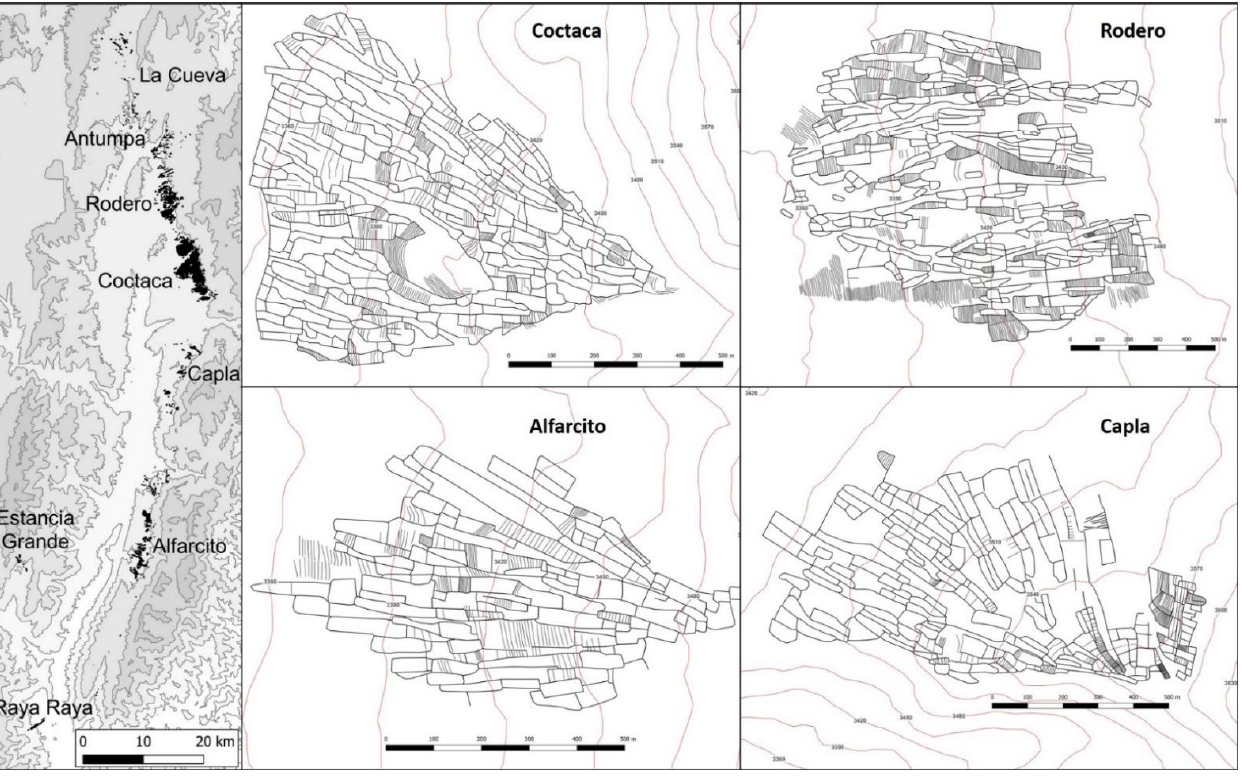
Figure 4. Structure of the pre-Hispanic agricultural substratum in different sectors of the high slopes of the Quebrada de Humahuaca.